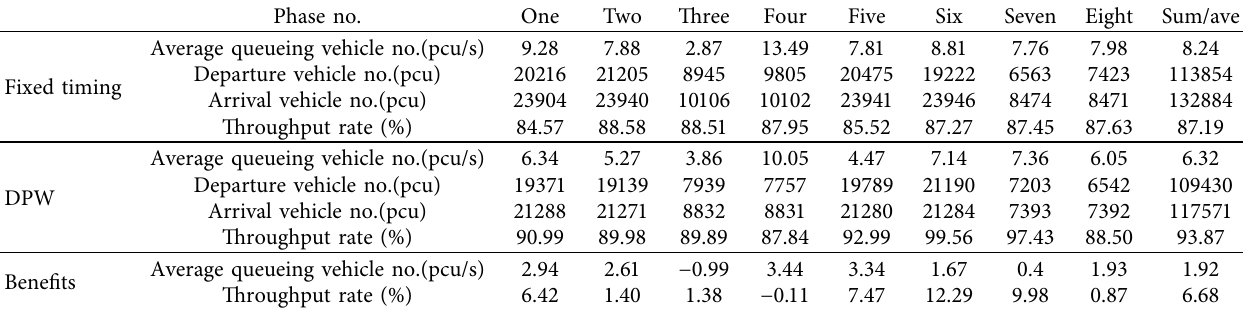
Table 3: Comprehensive performance parameter